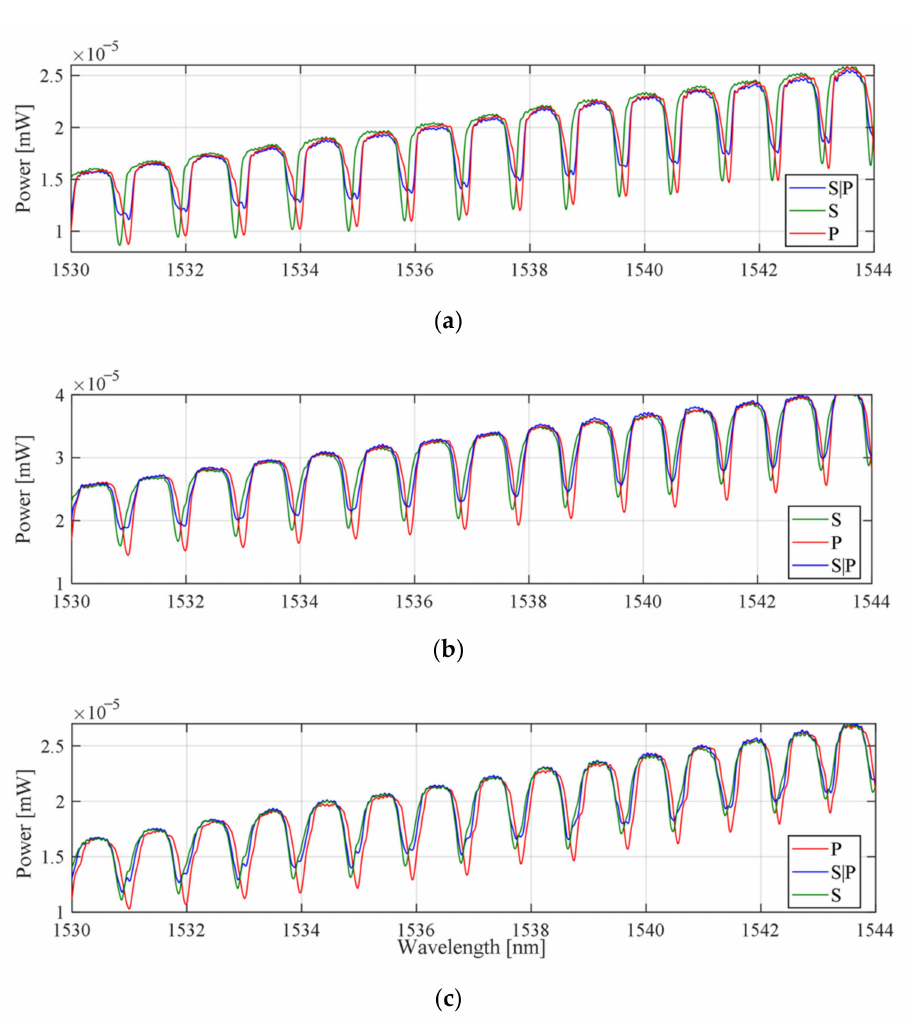
Figure 7. Results of spectral measurements of TFBG θ = 5 ◦ for three states of polarization of the input